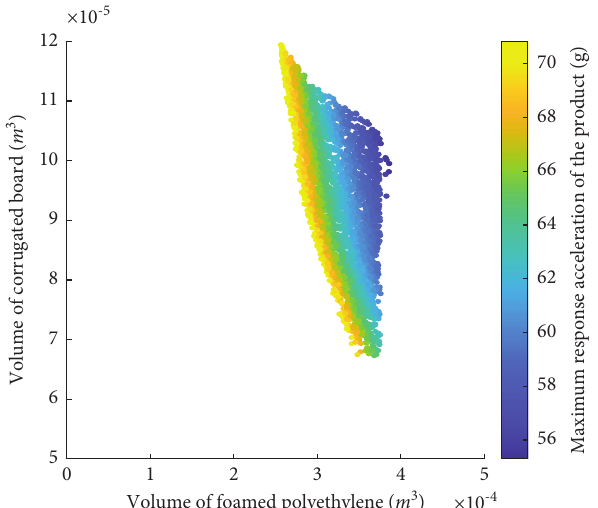
Figure 8: The non-dominated solutions set of the series cushioning system when the drop height is 0.7m.